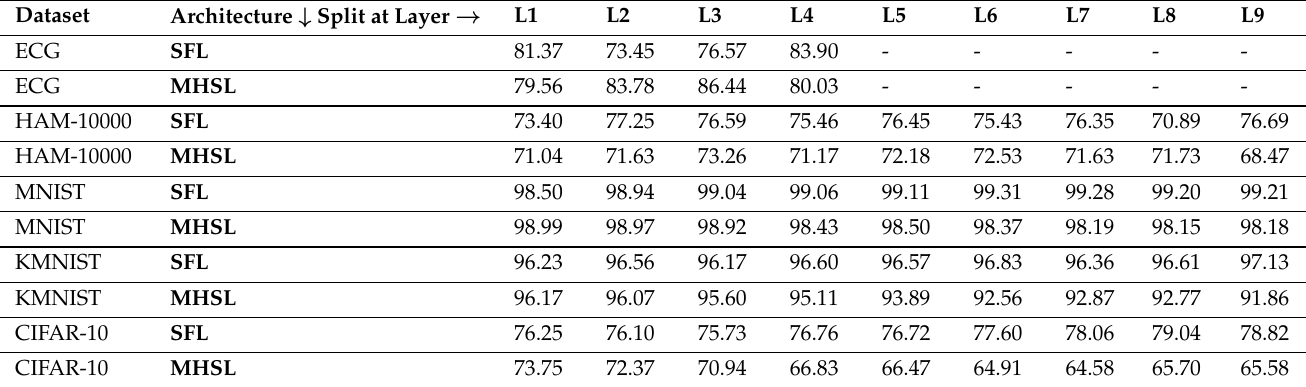
Table 6. Test accuracy with respect to the model split at different